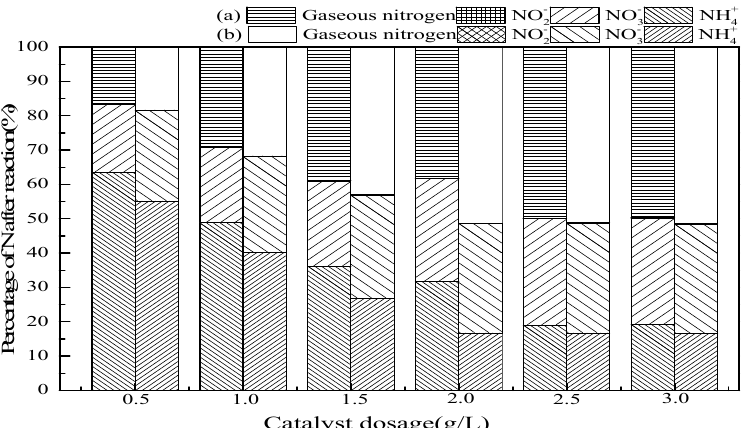
Figure 5. The effect of catalytic dosage on ammonia conversion. Reaction conditions: initial NH 4+ concentration 50 mg / L, initial pH 9.5, ozone flow 1.5 g / h, catalytic dosage from 0.5 g / L to 3.0 g / L, concentration 50 mg/L, initial pH 9.5, ozone flow 1.5 g/h, catalytic dosage from 0.5 g/L to 3.0 g/L, temperature 25 °C, reaction time 60 min, ultrasonic frequency 25 kHz, ultrasonic power 270 W, temperature 25 ◦ C, reaction time 60 min, ultrasonic frequency 25 kHz, ultrasonic power 270 W, ultrasonic ultrasonic operation 1 s and interval 2 s. ( a ) SrO-Al 2 O 3 /O 3 , ( b ) SrO-Al 2 O 3 /US/O 3. operation 1 s and interval 2 s. ( a ) SrO-Al 2 O 3 / O 3 , ( b ) SrO-Al 2 O 3 / US / O